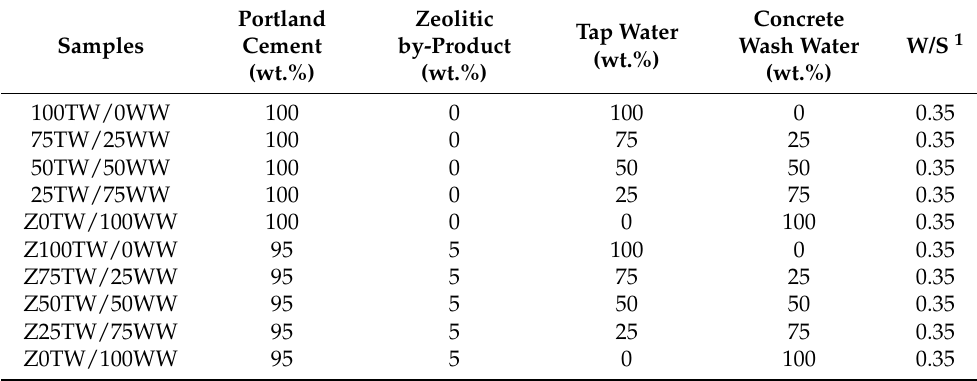
Table 3. The quantity of initial materials for the composition of cement